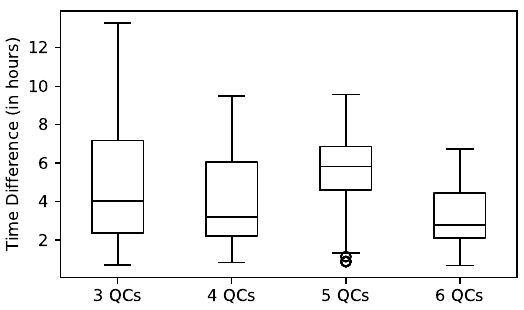
Figure 7. Time difference between maximum and minimum working times of